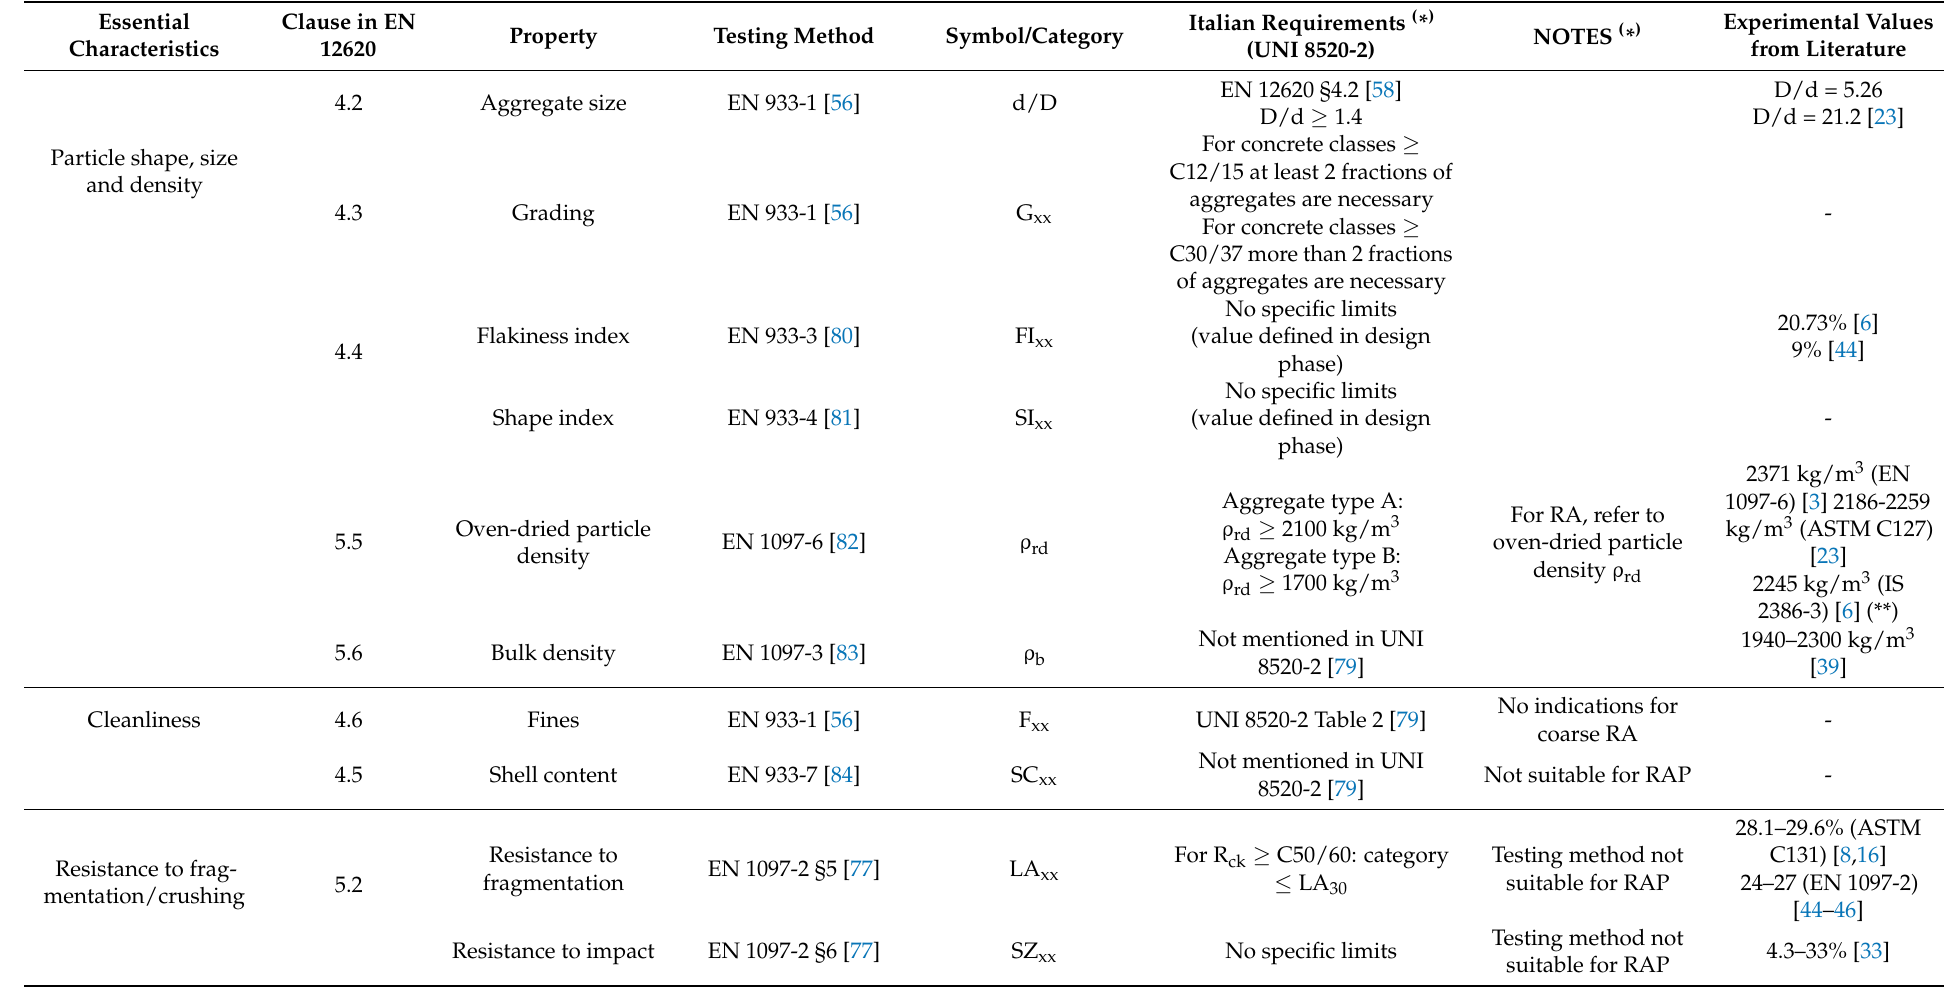
Table 4. Comparison between essential characteristics according to EN 12620, minimum requirements for application in Italy and experimental values from